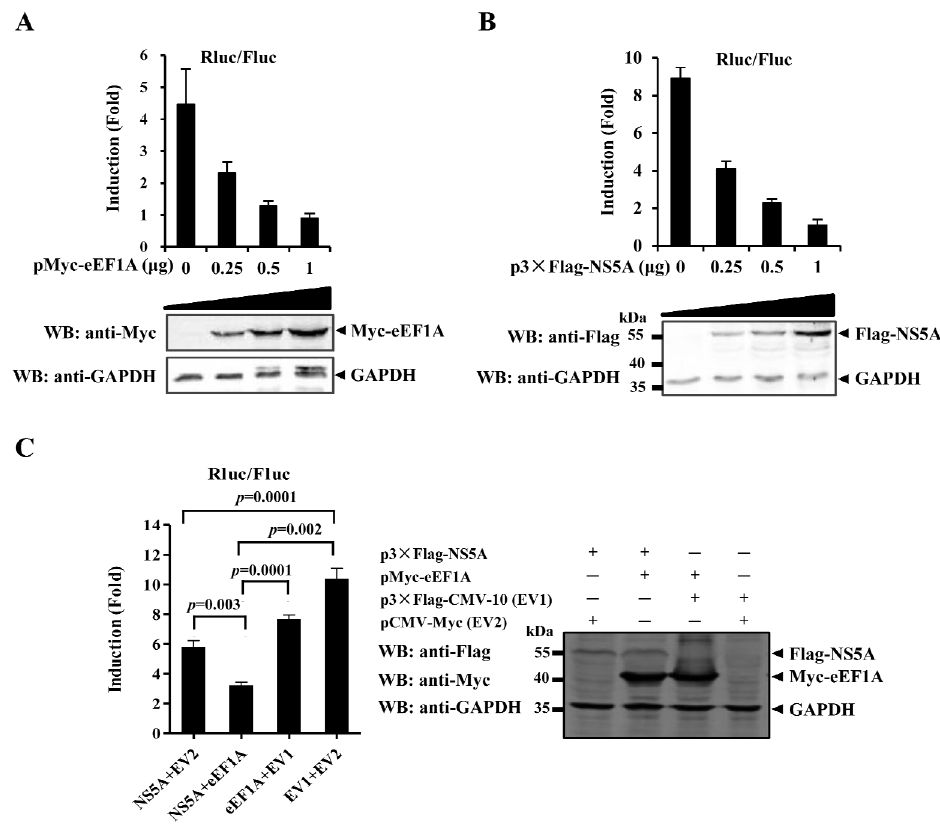
Figure 5. Overexpressed eEF1A or/and NS5A inhibits the CSFV internal ribosome entry site (IRES) activity. ( A ) eEF1A inhibitory effect on the CSFV IRES activity in a dose-dependent manner. The plasmids pCMV-Myc-eEF1A (0, 250, 500 or 1000 ng), pFluc/IRES/Rluc (750 ng) and pLXSN-T7 (300 ng) were cotransfected into HEK293T cells.